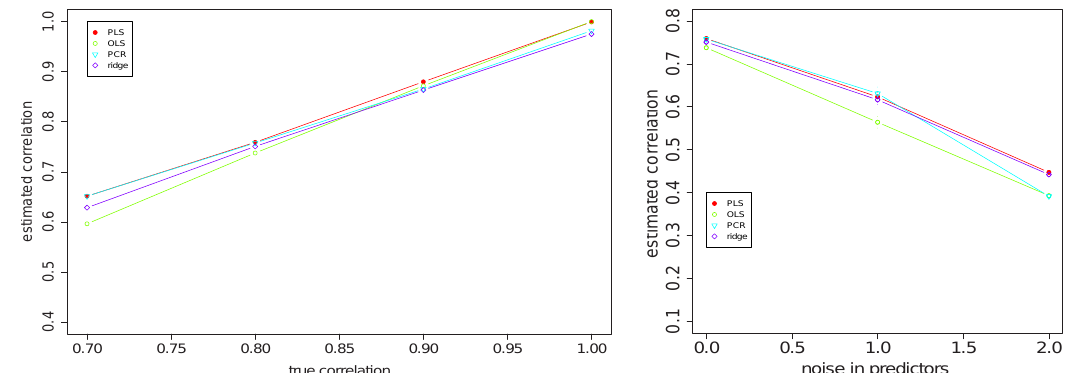
Figure 3: The predictive power of the regression methods as dependent on noise in the response (left) and noise in the predictors (right). Parameters to assess the relevance of noise in the response were σ p = 0 . 0 and p = 25 , for the right panel σ p /var ( X ) is displayed on the first axis. In both panels, the median estimated correlation over 30 different test sets is shown, the error bars depict the corresponding standard error of the mean.